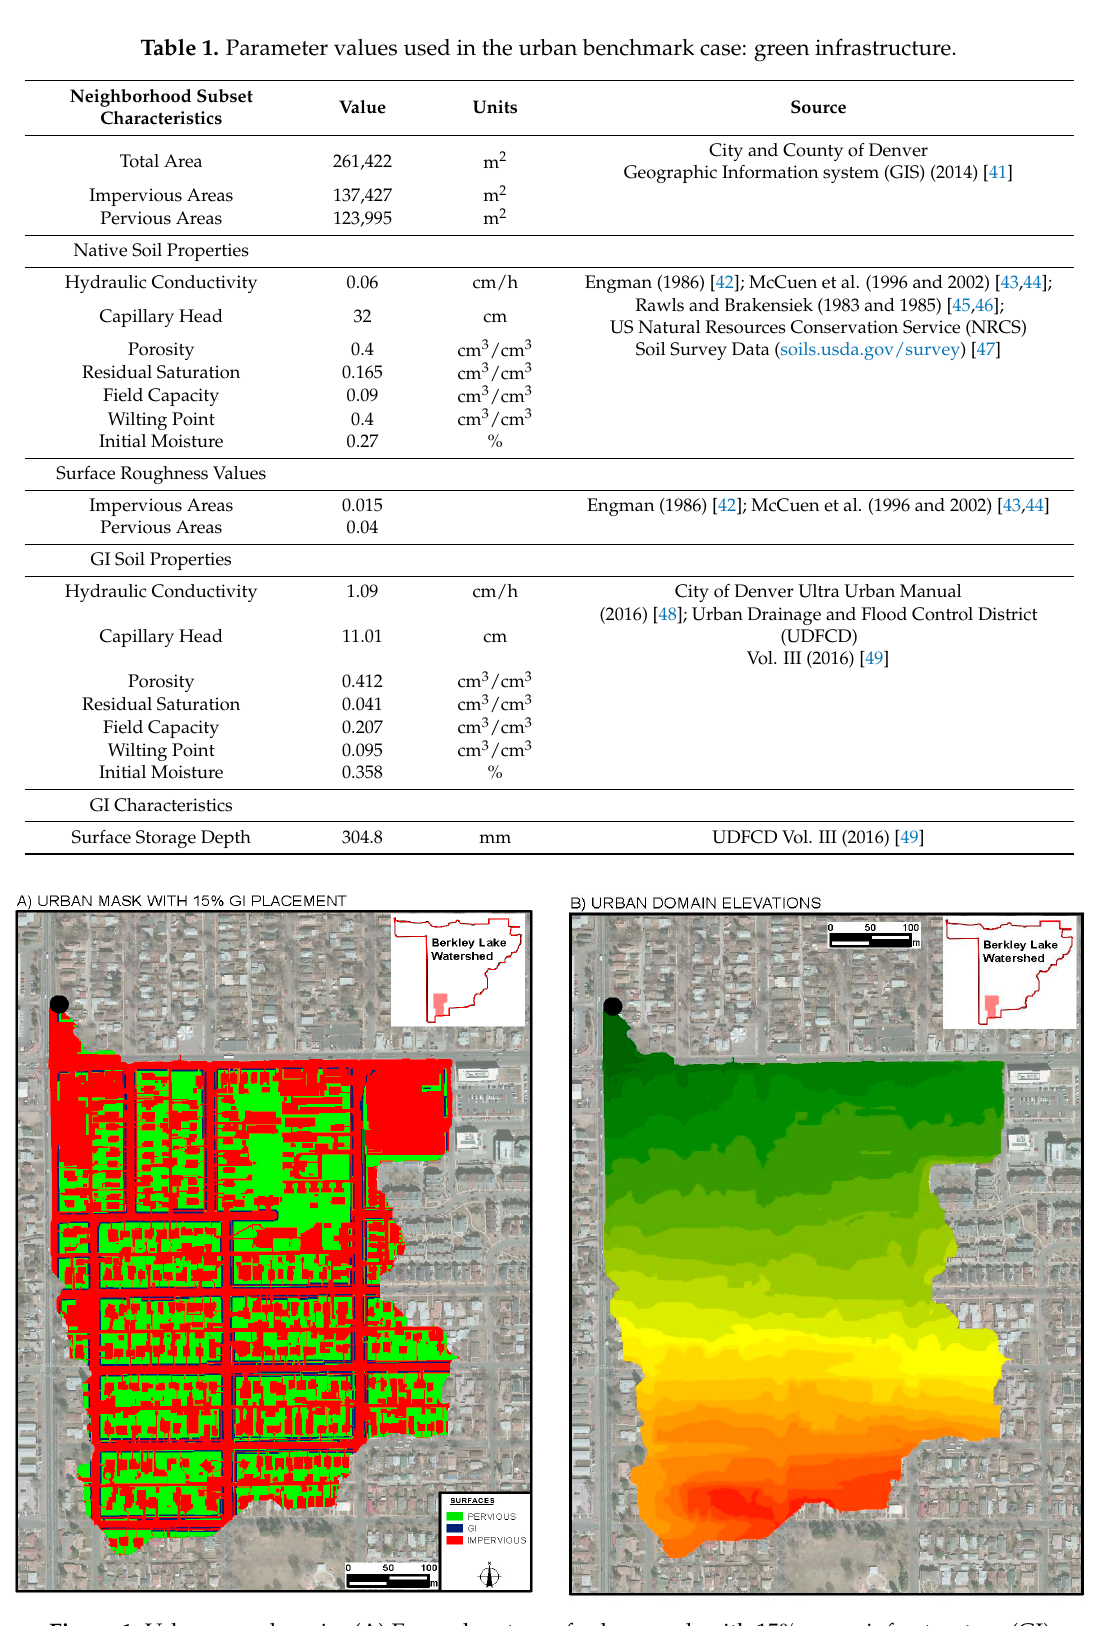
Figure 1. Urban case domain. ( A ) Example set up of urban mask with 15% green infrastructure (GI) placement; ( B ) Surface elevations based upon City and County of Denver 2008 Lidar Data. Table 1. Parameter values used in the urban benchmark case: green infrastructure.